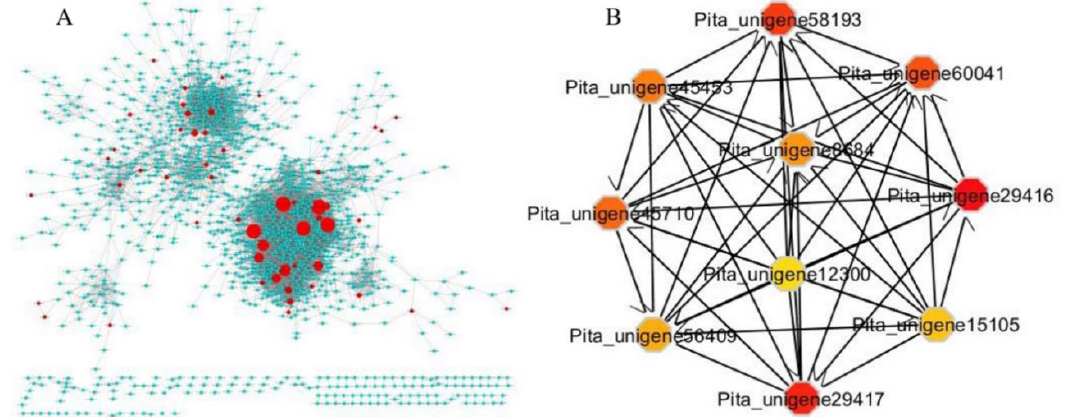
Figure 8. DEGs generate TFs network through Cytoscape ClueGo. ( A ) The networks were constructed based on interactions, co-expression, and gene fusion. ( B ) In every module, the top 10 ranked genes were hub genes, analysis with cytoHubba by degree centrality with a degree score. The size and color change of the nodes denoted the level of degree score.